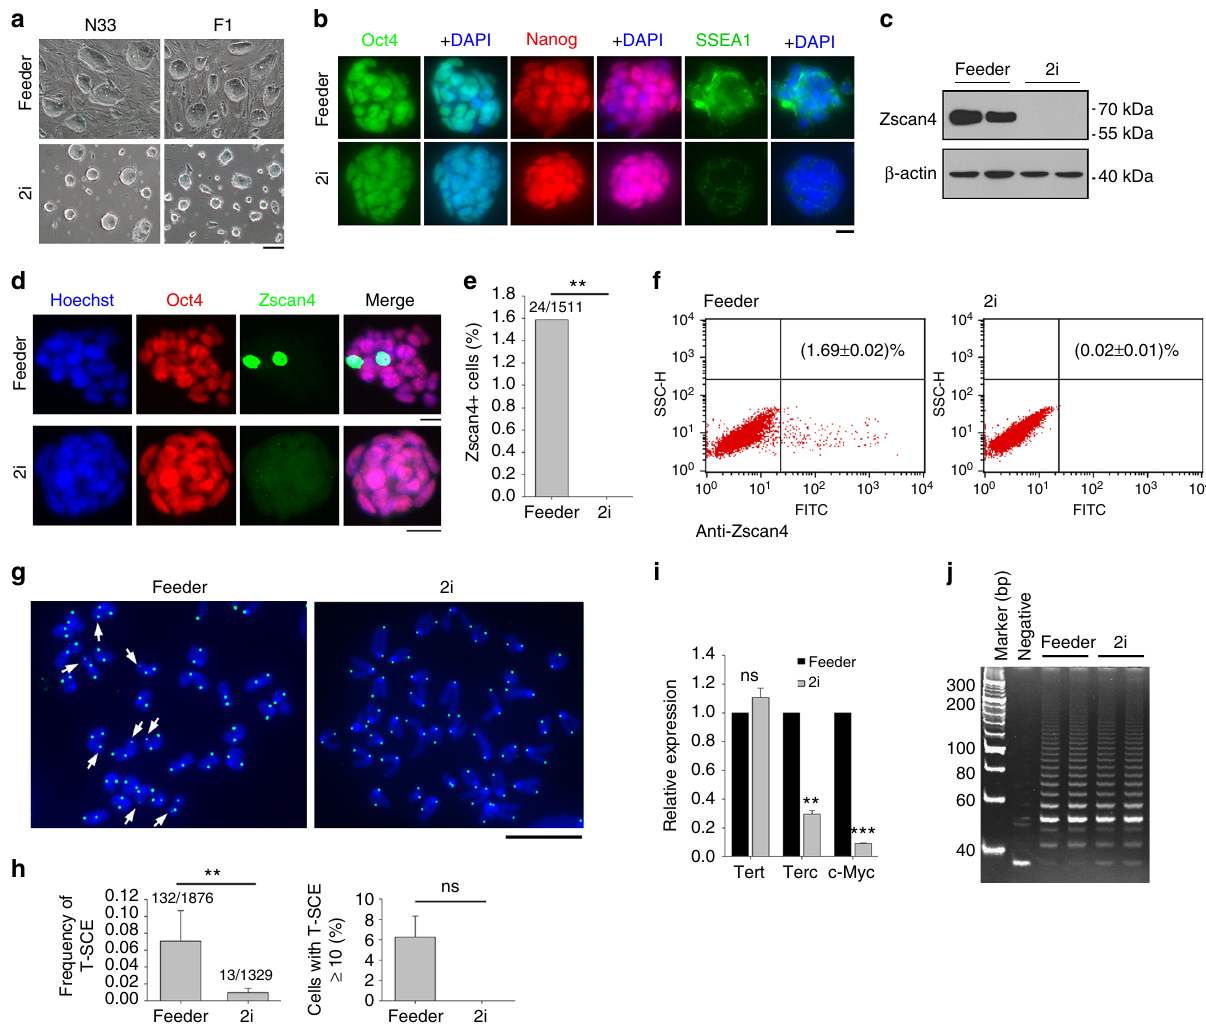
Fig. 6 2i repress Zscan4 and SSEA1. a Morphology under bright fi eld with phase-contrast optics of N33 and F1 ESCs cultured in serum + feeder + LIF (feeder) or N2B27 + 2i + LIF (2i) conditions. Scale bar, 100 μ m. b Immuno fl uorescence of pluripotency-associated markers Oct4, Nanog and SSEA1 in N33 ESCs ( fi ve passages). Scale bar, 10 μ m. c Zscan4 protein levels by western blot (three passages). d Immuno fl uorescence showing co-staining of Oct4 and Zscan4 in N33 ESCs. Scale bar, 10 μ m. e Percentage of Zscan4 + cells in ~1500 ESCs counted. f Flow cytometry quadrantal diagram indicating proportion of Zscan4 + cells in a ESC population. g Representative CO-FISH images showing T-SCE (indicated by white arrows) in feeder- and 2i- ESCs. Scale bar, 10 μ m. h Frequency of T-SCE (total T-SCE/total chromosomes) and percentage of ESCs with T-SCE foci ≥ 10. i Expression of telomerase-related genes Tert , Terc , and c-Myc in feeder- and 2i- ESCs. j Telomerase activity measured by TRAP assay. Lysis buffer served as negative control. ** P < 0.01, *** P < 0.001, ns not signi fi cant ( P > 0.05). Student ’ s t -test for i , and χ 2 test for e and